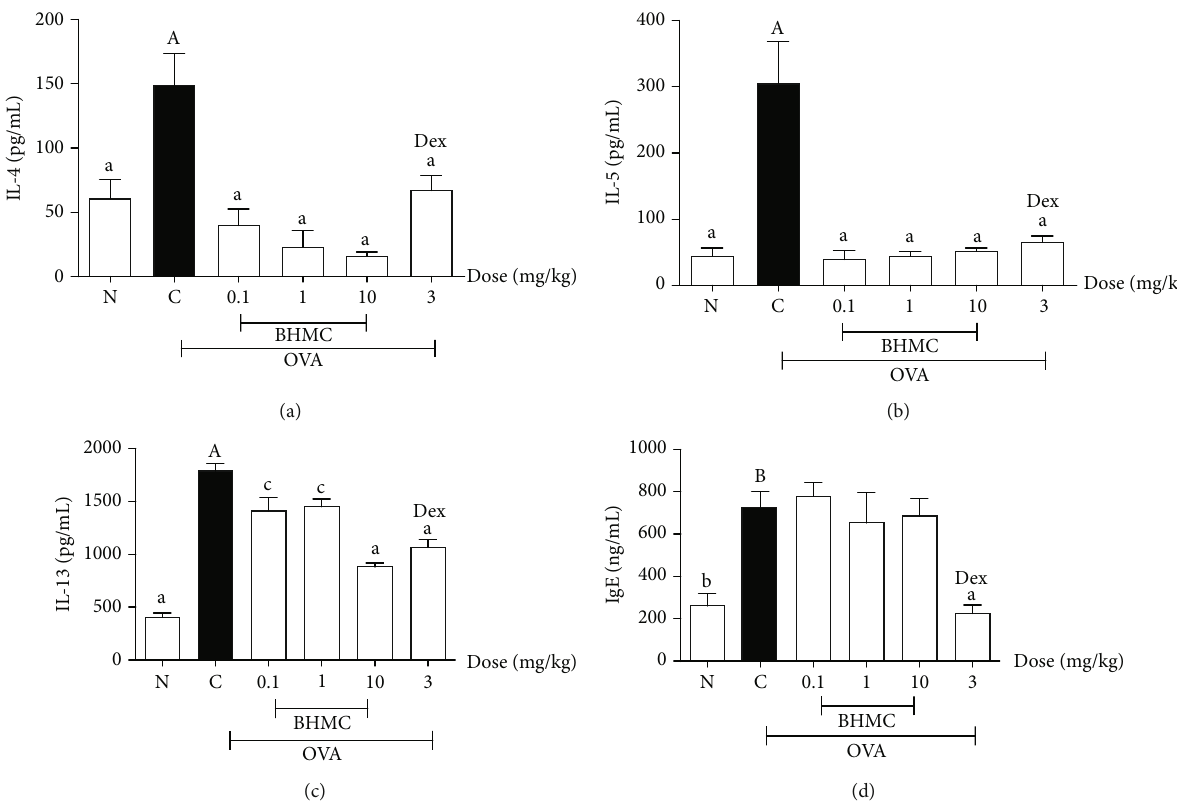
Figure 6: The e ff ects of BHMC on the levels of IL-4, IL-5, and IL-13 in BALF and serum IgE from OVA-induced acute asthmatic mice. The BALF was collected from euthanized mice ( n = 8 per group) and the levels of (a) IL-4, (b) IL-5, and (c) IL-13 were measured using ELISA kits. (d) The levels of IgE in serum was also measured by ELISA according to the manufacturer ’ s protocol. The values are expressed as mean ± SEM performed in triplicates. c: P < 0 : 05 and a: P < 0 : 005 , signi fi cantly di ff erent from the OVA group. B: P < 0 : 01 and A: P < 0 : 005 , signi fi cantly di ff erent from the N